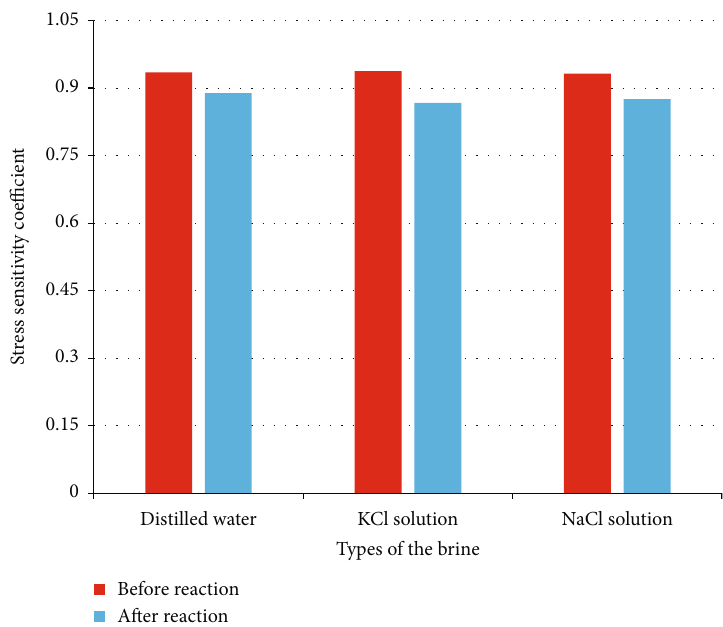
Figure 7: Stress sensitivity coe ffi cient of shale before and after interaction with di ff erent brine for 48 h.